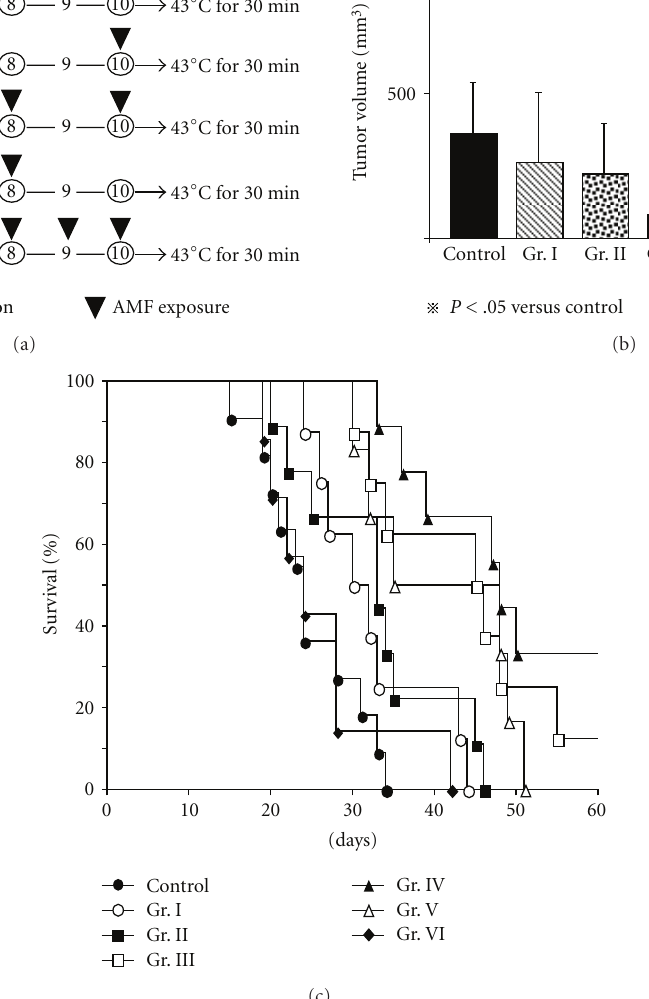
Figure 4: Time schedule and results for tumor volumes, survival periods, and rates of mice treated by Protocol number 2. (a) Protocols of Groups I, II, III, IV, V, and VI. (b) Tumor volumes on day 14 after re-challenge with B16F1 melanoma. All data are presented as mean ± standard deviation. Tumor volumes of Groups III and IV were found to be significantly reduced compared with those of the control group ( P = . 0411 and . 0195, resp.) and Group VI ( P = . 0444 and . 0237, resp.) by the Sche ff ´e test. (c) Kaplan-Meier survival curves over a period of 60 days after re-challenge with B16F1. The survival rate of Group III was significantly prolonged compared with those of the control group ( P = . 0006) and Group VI ( P = . 0013). The survival rate of Group IV was significantly prolonged compared with that of the control group ( P < . 0001), Group I ( P = . 0014), Group II ( P = . 0014), and Group VI ( P = . 0013). One of the eight mice in Group III and three of the nine mice in Group IV were protected against re-challenge with B16F1 melanoma